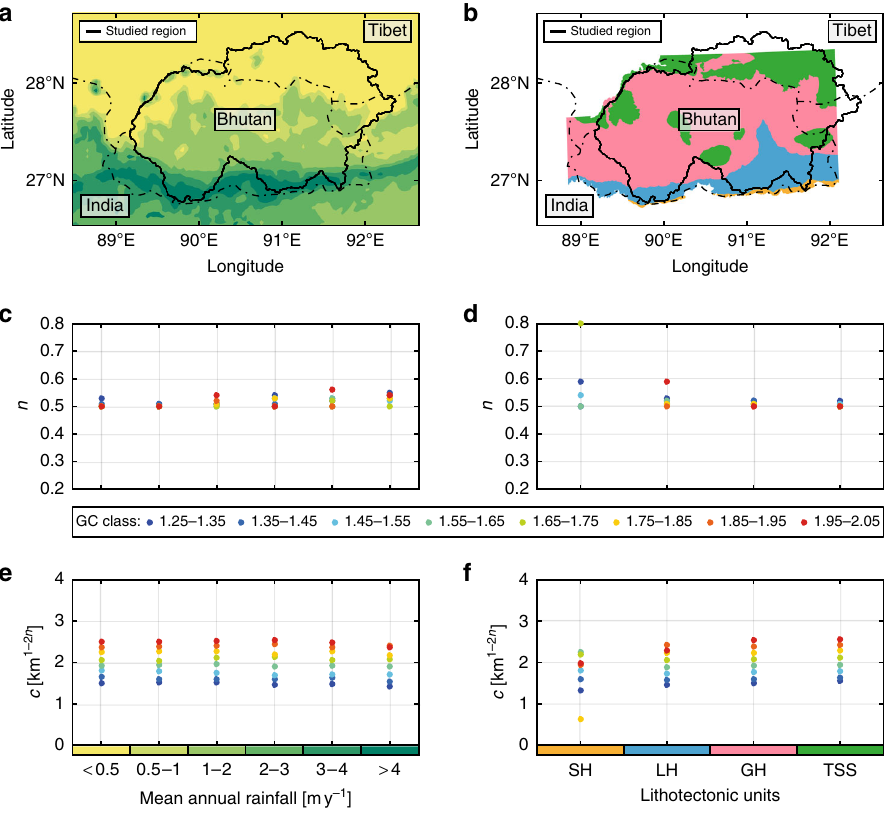
Fig. 7 Rainfall and lithological effects on Hack ’ s parameters for different classes of basin shapes. a , b Maps of the six main rainfall classes 16 and the four major geological units in Bhutan 17 . c – f In fl uence of rainfall ( c , e ) and lithology ( d , f ) on Hack ’ s exponent ( c , d ) and coef fi cient ( e , f ). Colours of dots indicate the GC class as shown in Fig. 1. Geological units are: Siwalik Hills (SH), Lesser Himalayas (LH), Greater Himalayas (GH) and Tethyan Sedimentary Series (TSS). Hack ’ s exponent shows dispersion of GC values within a given rainfall or lithology class but remains generally constant. Hack ’ s coef fi cient remains constant for a given GC class regardless of rainfall or lithology. The SH lithology class displays very strong dispersion associated with a scarce dataset (13 basins) and is discarded from our analysis